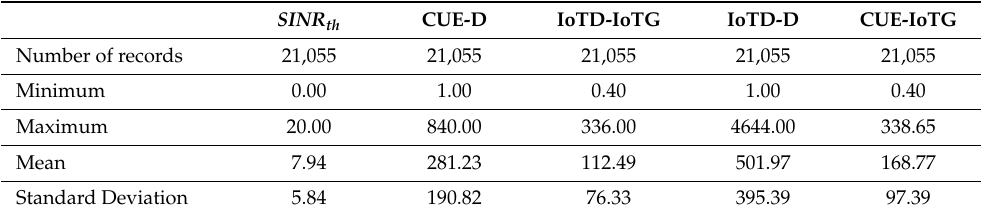
Table 2. Statistical description of features in the generated uplink dataset.